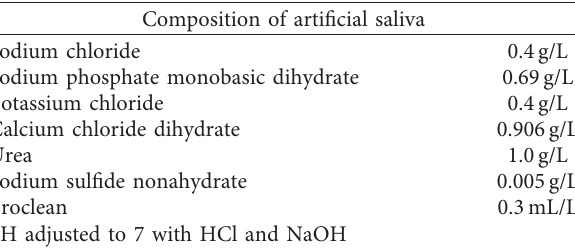
Table 2: Composition of artificial